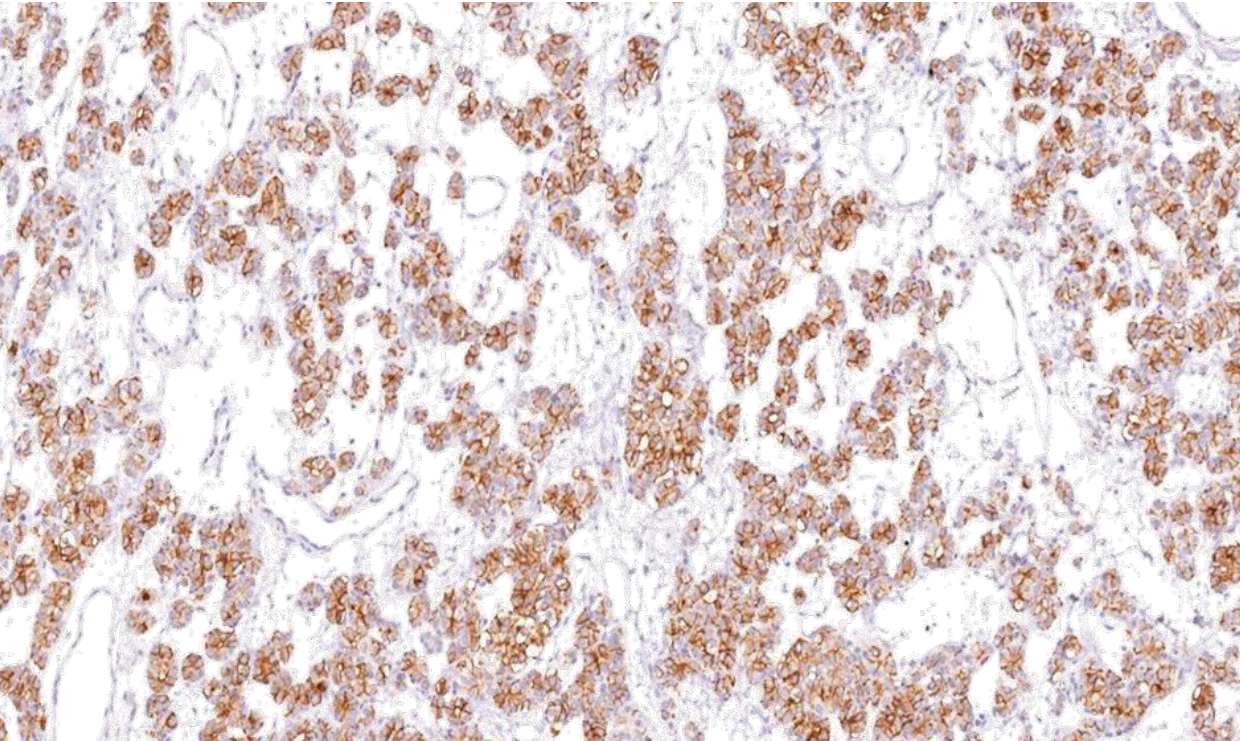
Figure 9. Galectin-3 staining shown nuclear and membranous staining as brown stain after IHC in apillary thyroid carcinoma; (labelled) (Magnification ×100).